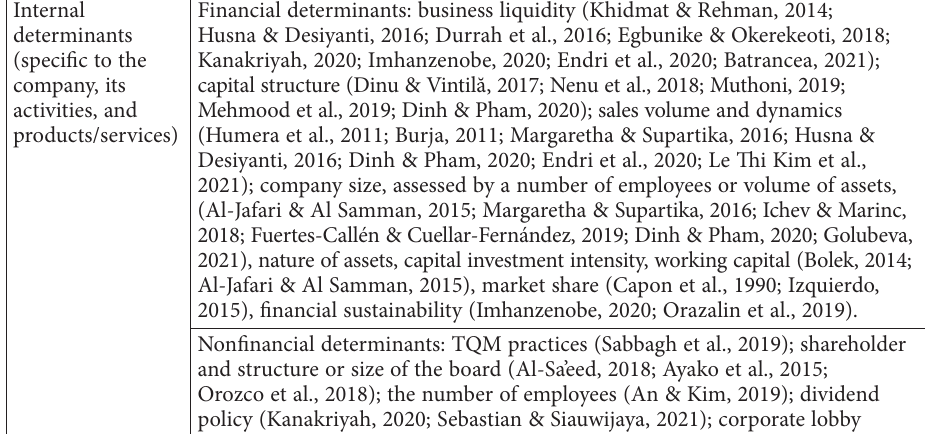
Table 1. Determinants of financial performance (source: elaborated by the authors) Internal determinants (specific to the company,